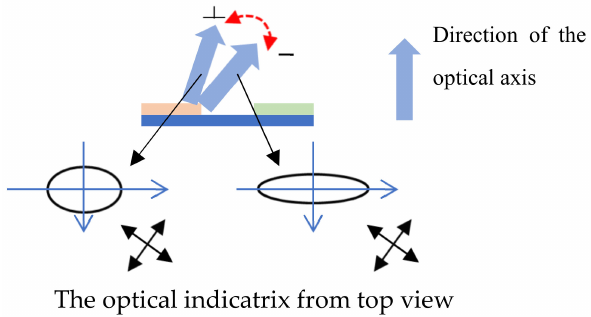
Figure 6. The illustration of the optical-axis reorientation due to the flexoelectricity, while the field polarity is